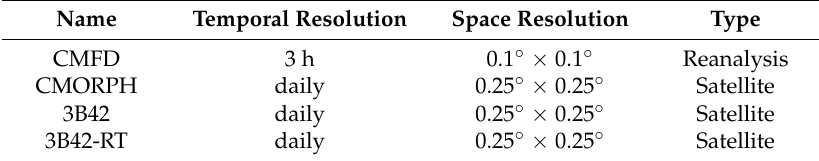
Table 2. Summary information for the four satellite precipitation products used in this